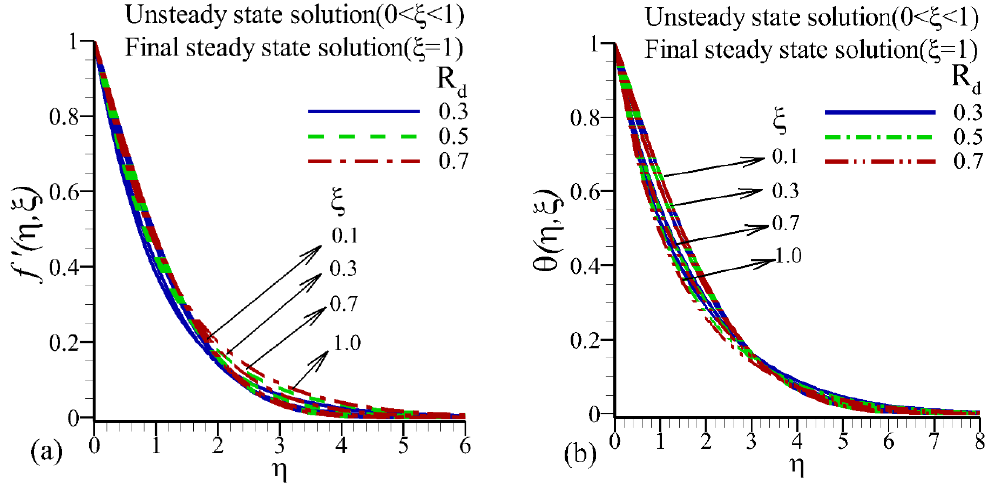
Figure 10. ( a ) Velocity ( , ) f , ( b ) Temperature ( , ) against for 0.3,0.5 d R